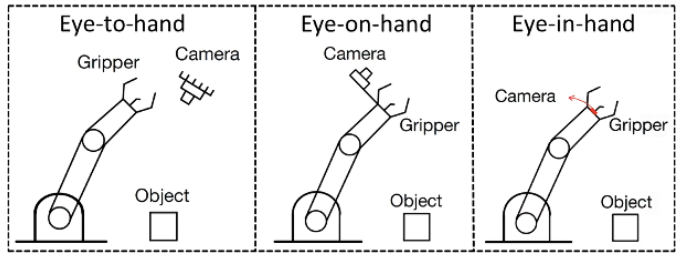
Figure 1. Relationship between the camera and gripper in different configurations.